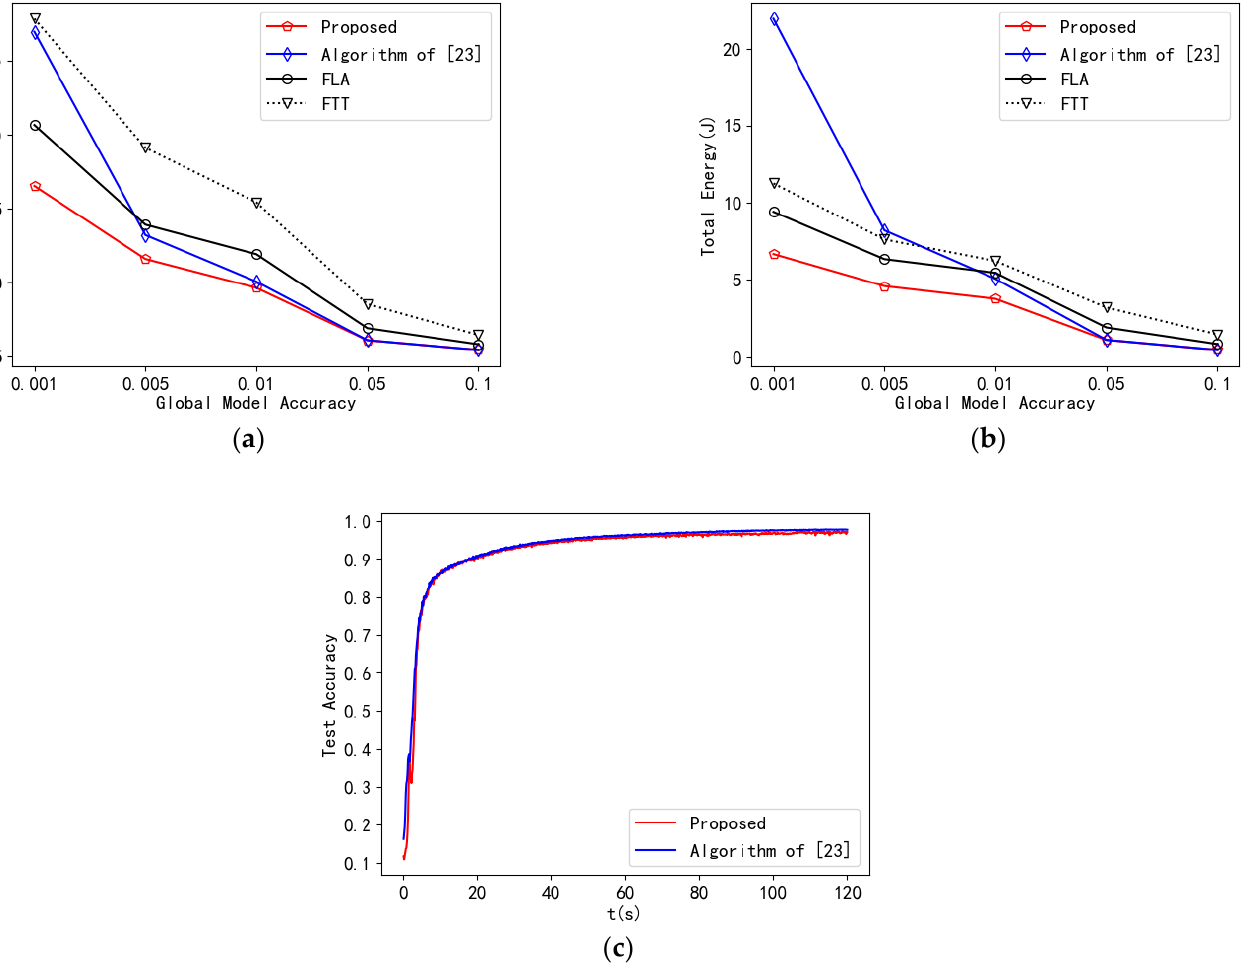
Figure 4. Global Model Accuracy Influence on Performance: ( a ) total system cost; ( b ) total energy consumption of users; ( c ) learning performance.